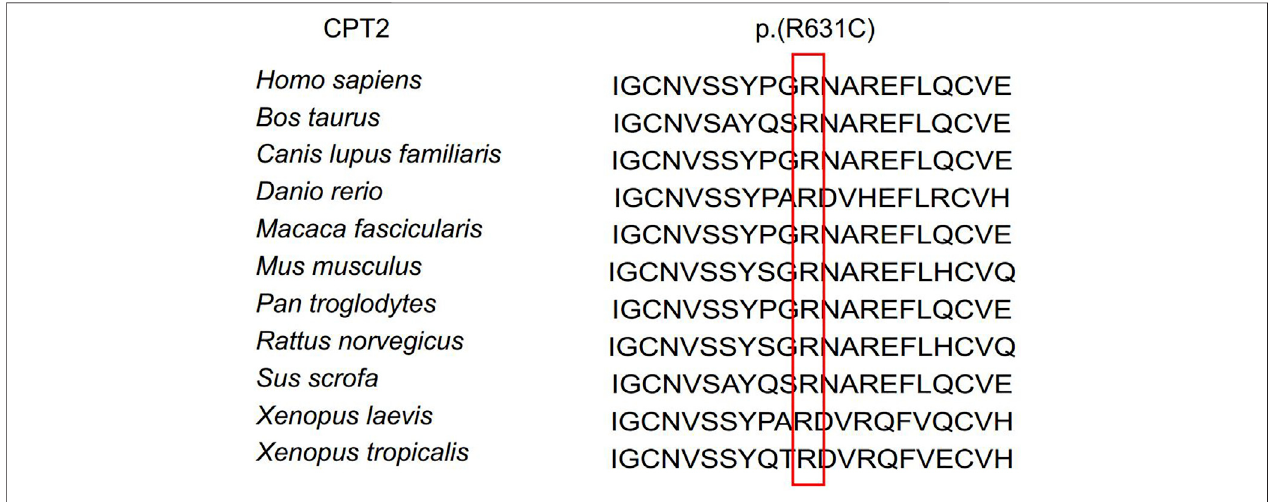
FIGURE 2 | Conservation analyses. Conservation analyses of the mutated residues 631 in CPT2 across different species.